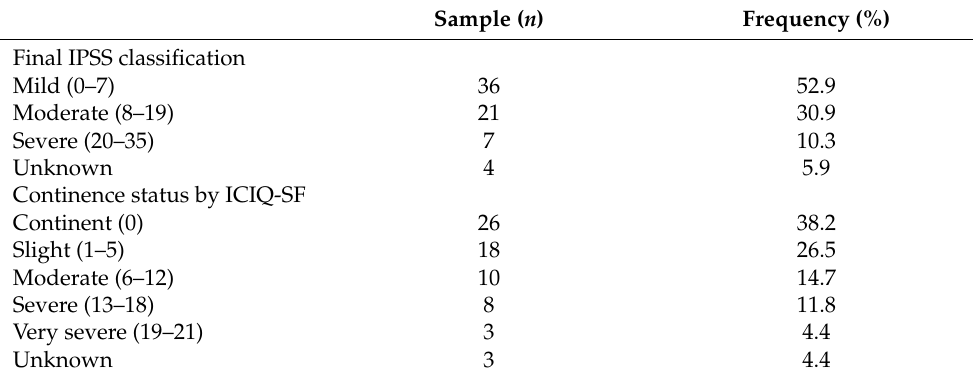
Table 4. Self-reported information on urinary incontinence (UI) and bladder symptoms according to the International Prostate Symptoms Score (IPSS) and International Consultation on Incontinence Questionnaire-Short Form (ICIQ-SF) among 68 residents living in five nursing homes (NHs) from Osona, Spain (2020).